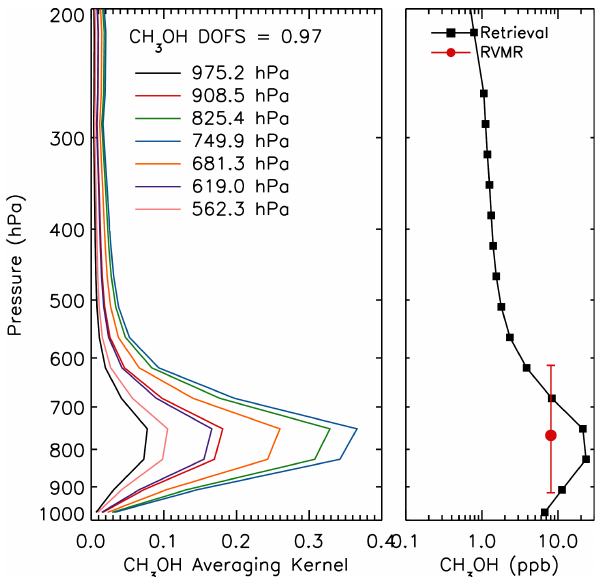
Fig. 6. Averaging kernel (left) and retrieved methanol profile (right) from the TES spectrum in Fig. 5. The red circle shows the methanol Representative Volume Mixing Ratio (RVMR) and the red lines show the vertical extent over which the RVMR